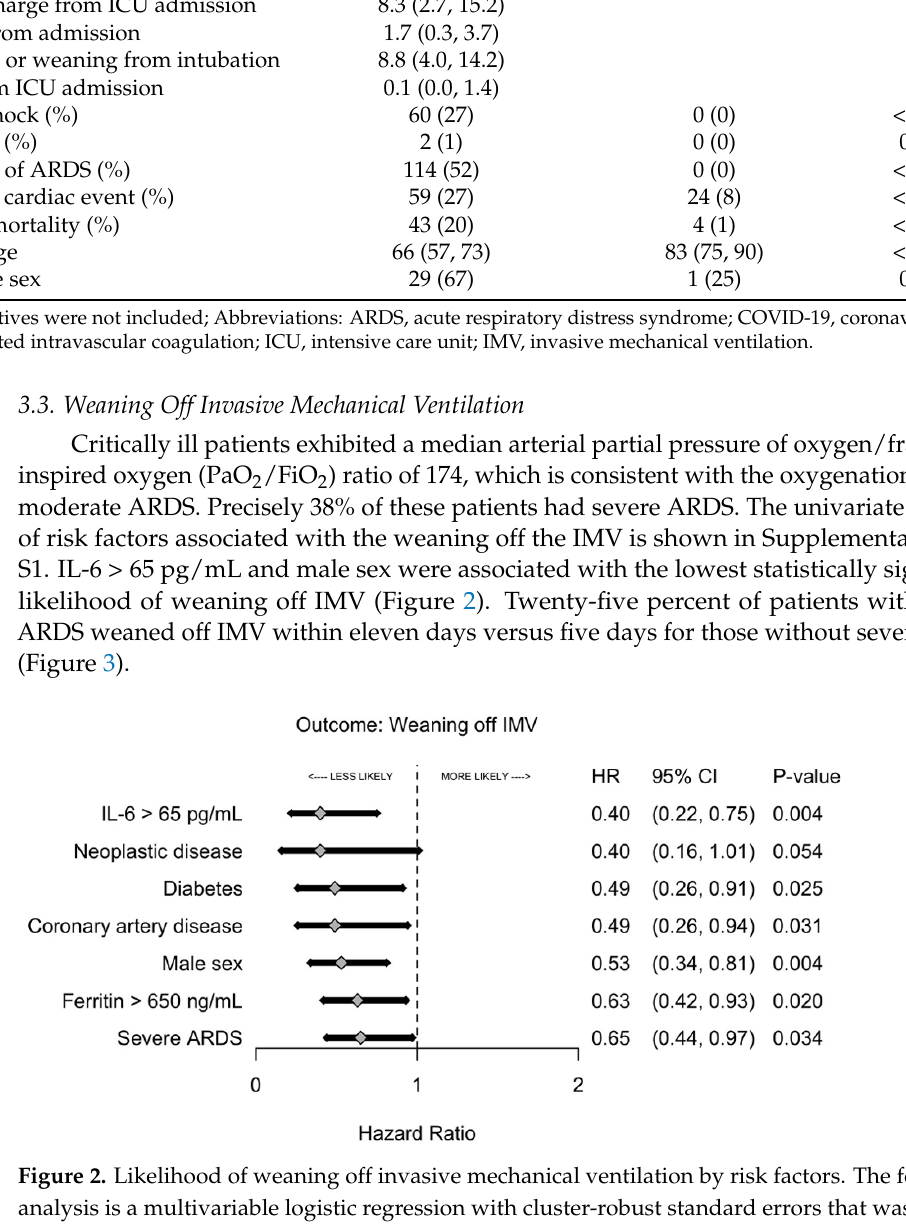
Table 2. Clinical outcomes among all patients hospitalized with COVID-19 pneumonia.